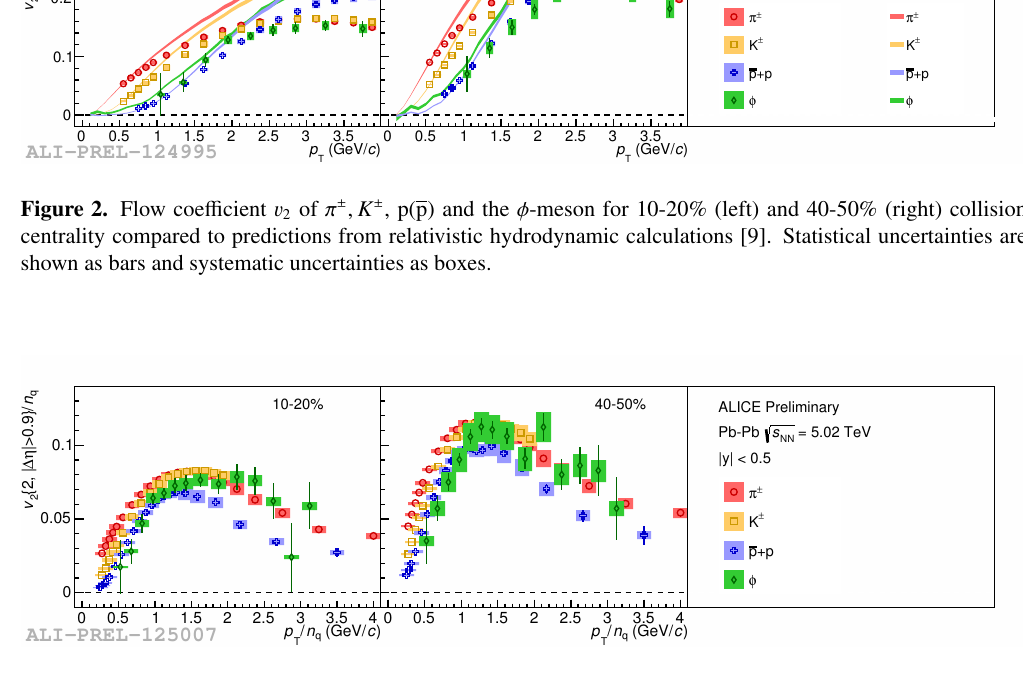
Figure 3. Scaling test for p T -di ff erential v 2 of π ± , K ± , p(p) and the φ -meson for 10-20% (left) and 40-50% (right) collision centrality, The x and y axes are scaled by the number of constituent quarks n q for each species − − independently. Statistical uncertainties are shown as bars, systematic uncertainties as